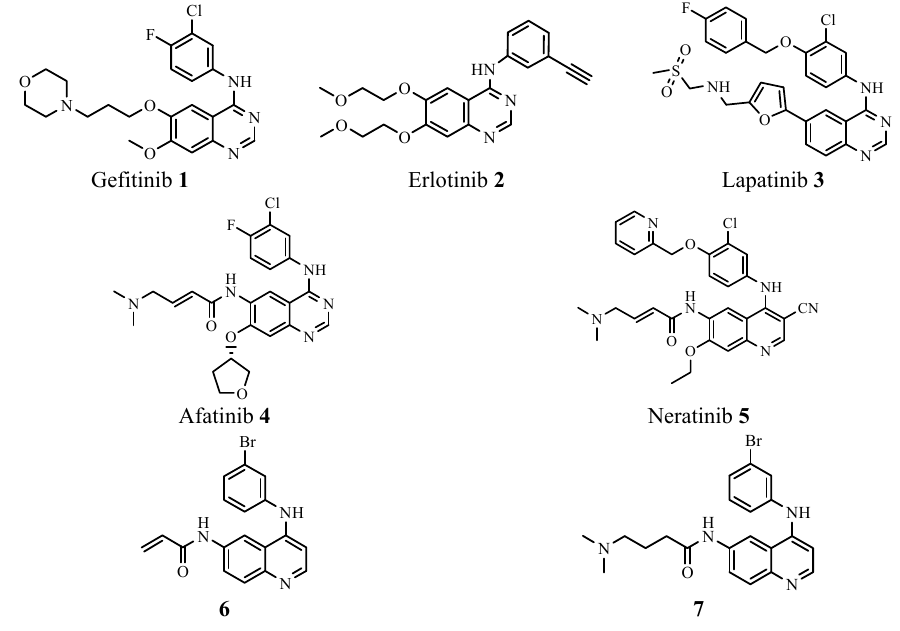
Figure 1. Several inhibitors of EGFR tyrosine kinases.